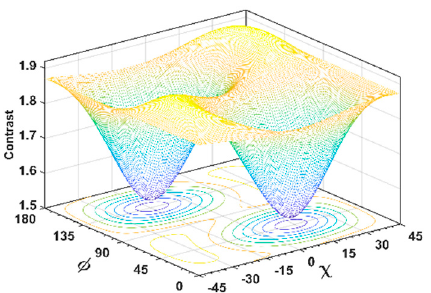
Figure 1. A 3D view of the focusing capability of a reconstructed vertical profile in different polarization bases.